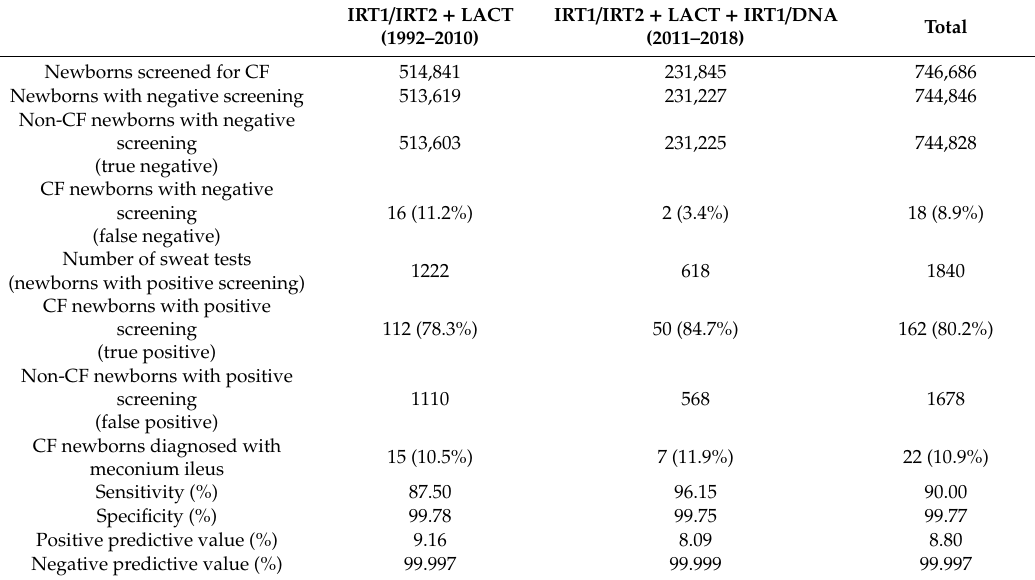
Table 1. Data from the 1992–2018 Cystic fibrosis newborn screening (CF NBS). Percentages as related to all cystic fibrosis (CF) cases of column are included in parentheses.